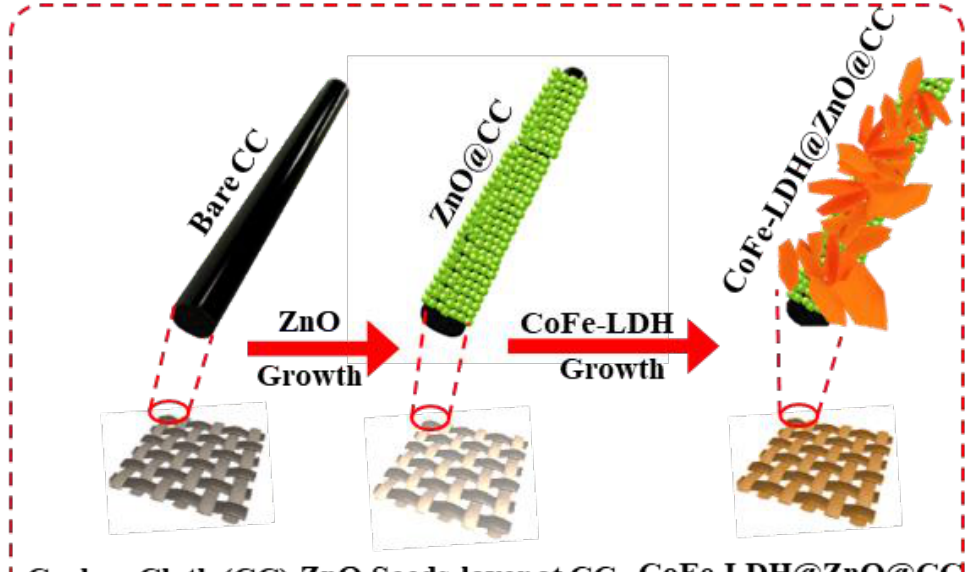
Figure 1. Synthesis process forming CoFe-LDH@ZnO@CC.